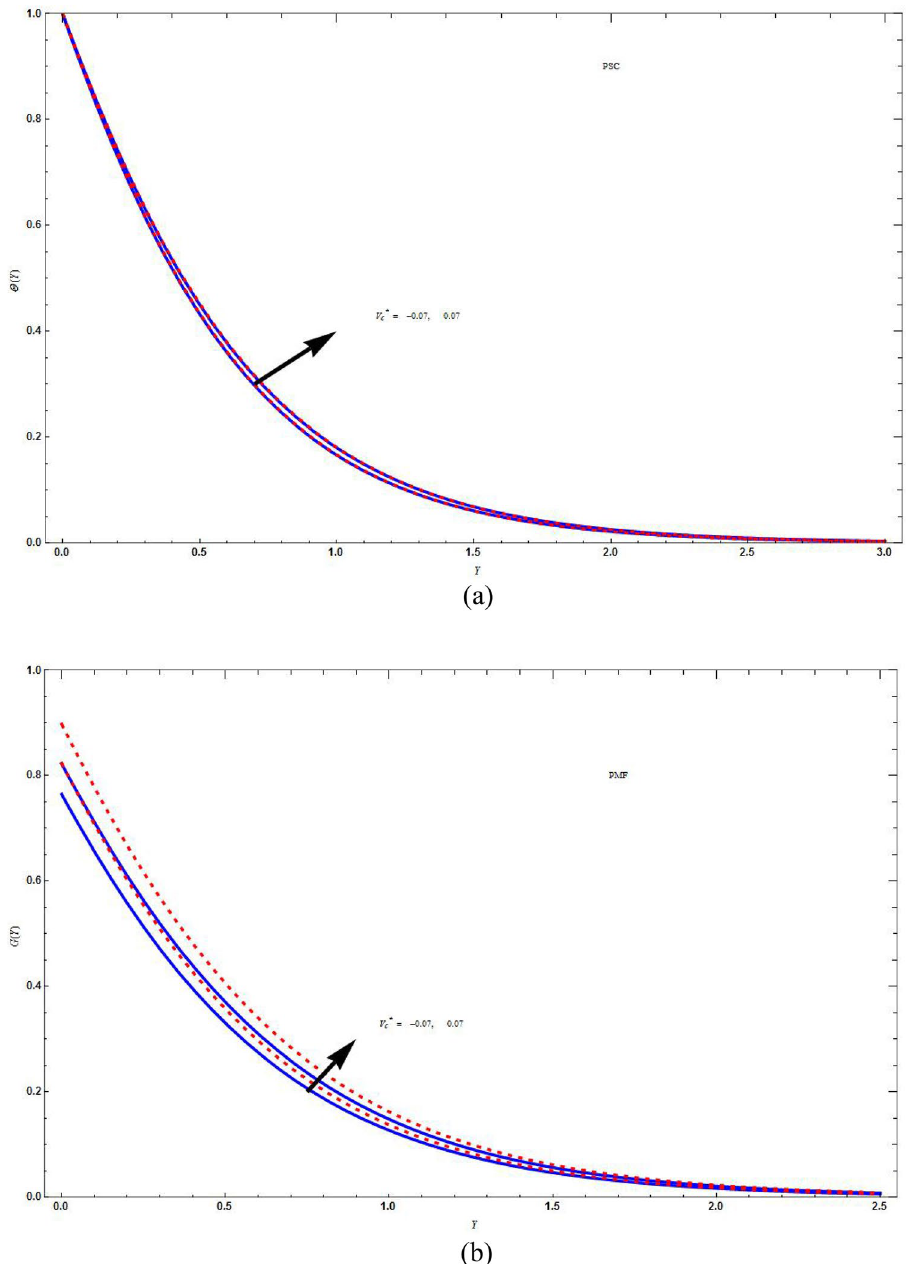
Figure 6. The concentration distribution plot for different V ∗ C keeping the parameters as 1 , ϑ 3, r 2, � 0.1 in ( a ) PSC case and in ( b ) PMF case. Blue solid lines M C Sc K � ∗ = = = = = = = − = − are for the base fluid and red dotted lines denotes the hybrid nanofluid Cu